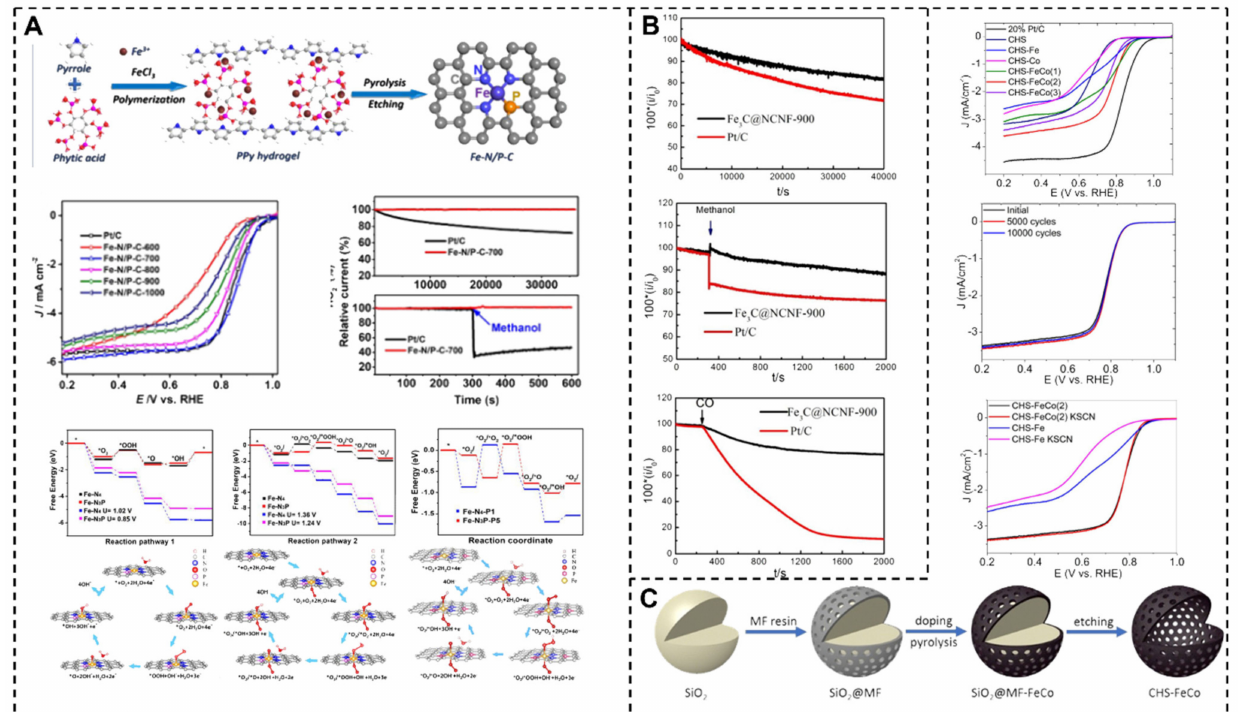
Figure 4. ( A ) Schematic illustration of the synthesis process of the Fe-N/P-C catalyst, ORR polariza- tion curves of Fe-N/P-C, tolerance to methanol and current − time chronoamperometric responses and the Gibbs free energy diagrams of ORR on Fe-N4 and Fe-N3P active sites [34]. ( B ) Durability evaluation from the current-time chronoamperometric responses, and i-t curves for CO-poison and the methanol-crossover effect [30]. ( C ) Elementary diagram of the preparation of CHS-FeCo, and polarization curves of different CHS instances, and stability test of CHS-FeCo, and ORR polarization curves with KSCN added